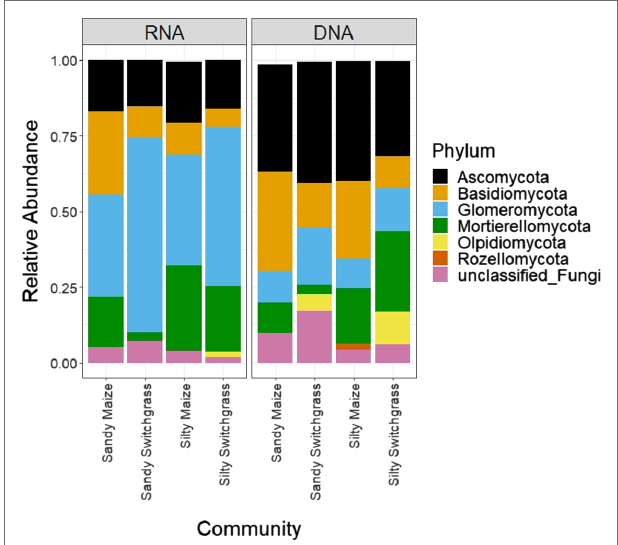
FIGURE 1 | Relative normalized abundance of fungal phyla separated by site/crop combination based on sequencing of ITS rRNA gene fragments of RNA and DNA ( n =